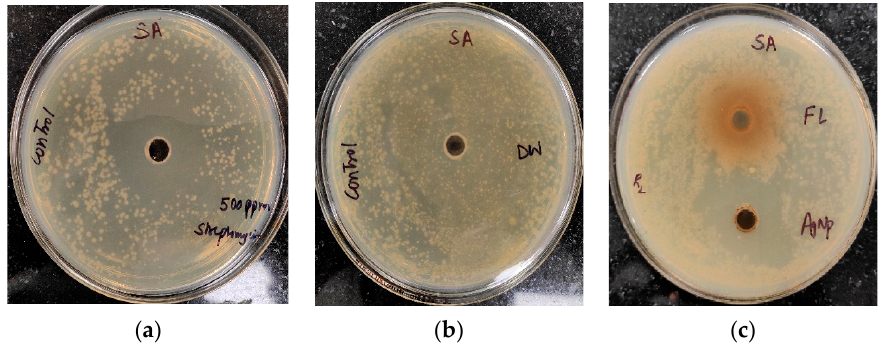
Figure 7. Antibacterial activity against Staphylococcus aureus (SA): ( a ) positive control (streptomycin); ( b ) negative control (distilled water (DW)); ( c ) leaf extract (FL) and AgNPs.